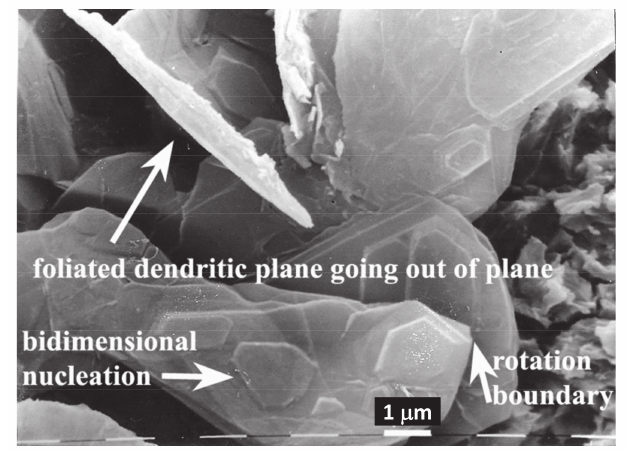
Figure 15. Foliated